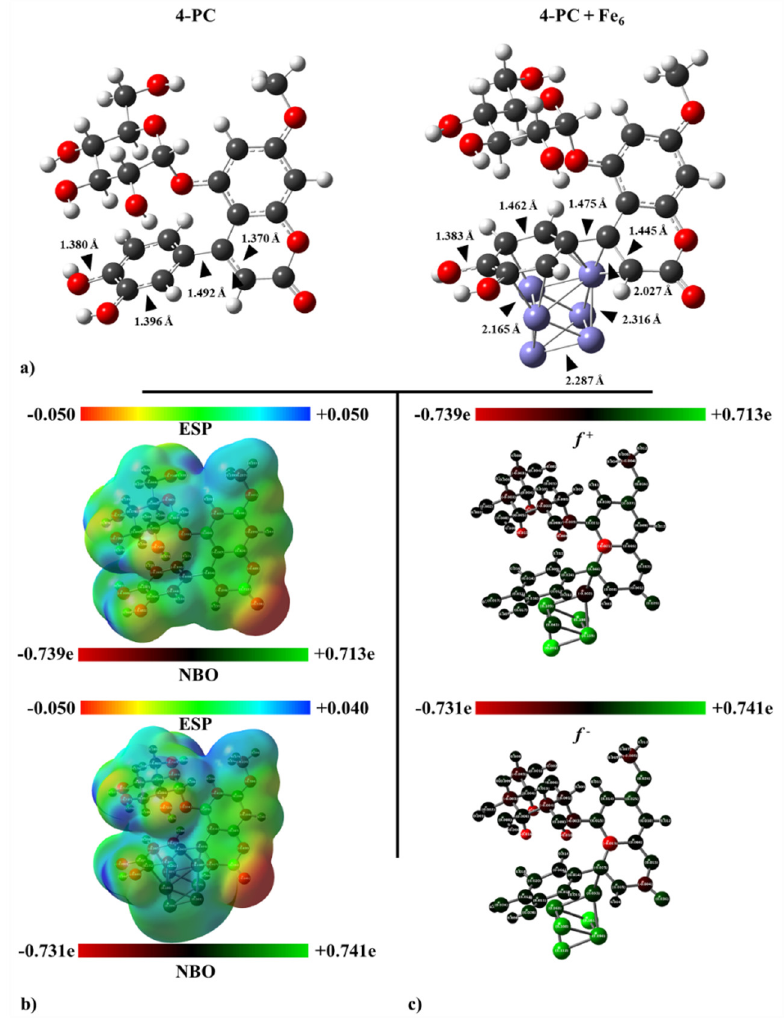
Figure 13. ( a ) Optimized structures and relevant bond lengths of the 4-PC molecule, isolated and interacting with the Fe 6 . ( b ) NBO charge distribution and ESP, mapped on isosurfaces with 0.0004 a.u. of the electron density, of the 4-PC molecule, isolated and interacting with the Fe 6 . ( c ) Condensed Fukui indices for nucleophilic and electrophilic attacks, f + and f − , calculated for the 4-PC molecule, isolated and interacting with the Fe 6 , calculated by means of NBO charges. Results obtained at the BPW91-D2/6-311++G(2d, 2p) level.